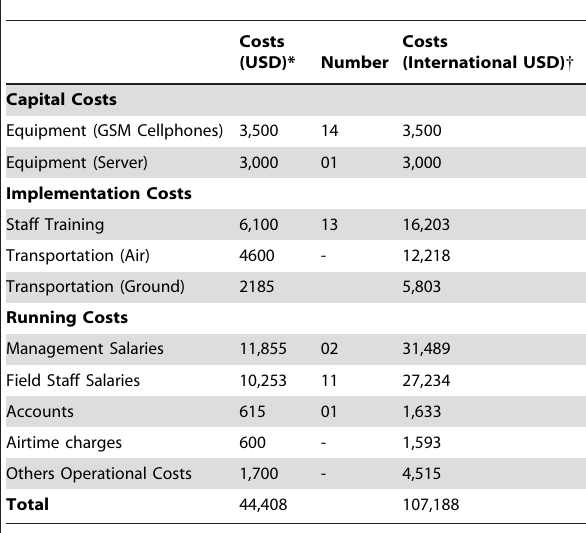
Table 4. Costs of mobile phone based dog-bite and rabies surveillance system implemented at nine emergency rooms in Pakistan, Feb 2009–Feb